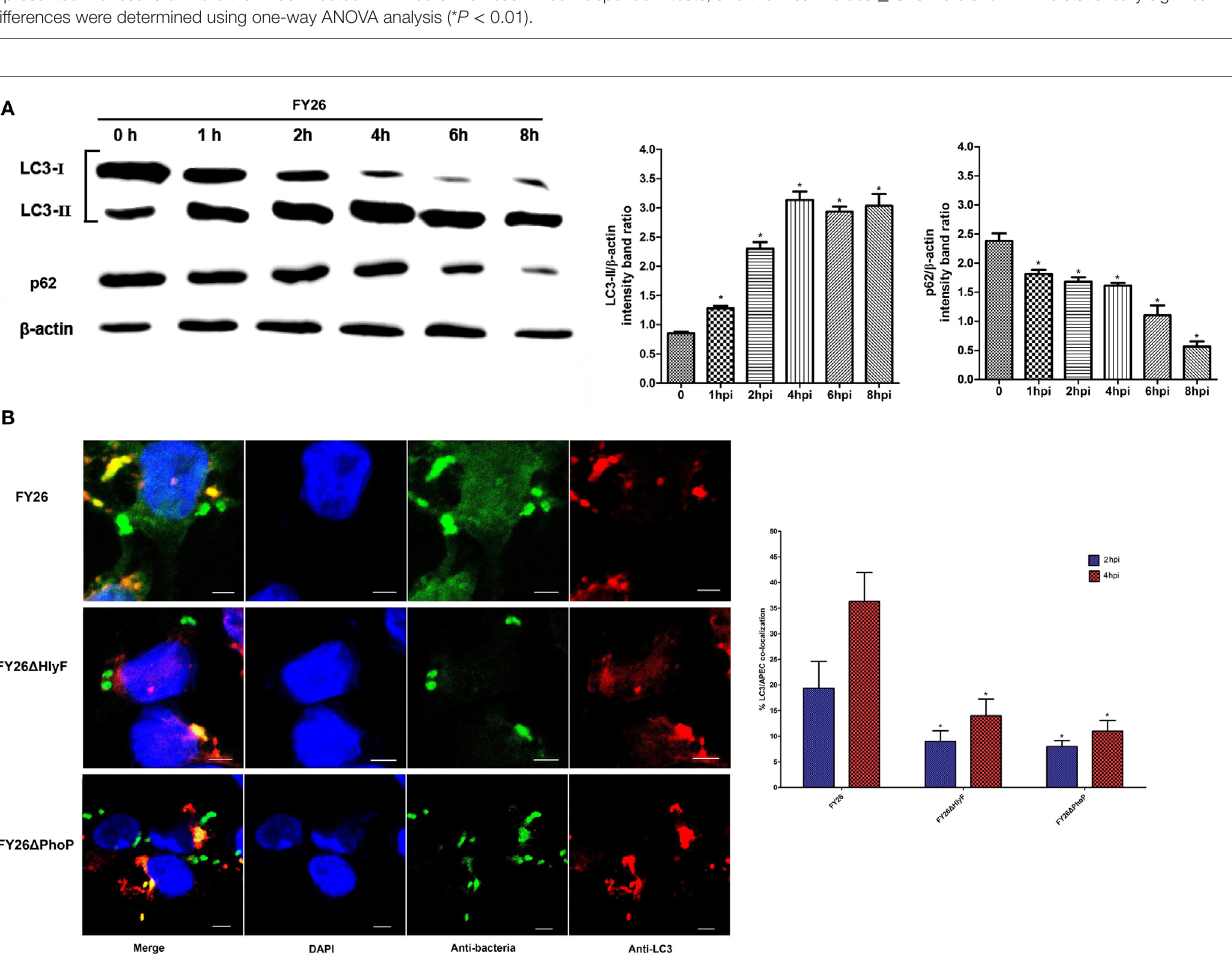
FigUre 6 | PhoP/PhoQ-HlyF pathway promoted the formation of extraintestinal pathogenic Escherichia coli (ExPEC)-containing autophagosome during survival in macrophages. (a) Western blots of LC3 and p62 in FY26-infected HD11 cells. HD11 cells were infected with FY26 at multiplicity of infection (MOI) of 50. At 1, 2, 4, 6, or 8 h post-infection (hpi), the cells were lysed, and SDS-PAGE was performed. Western blot using antibodies against LC3, p62, and β -actin protein as indicated. Densitometry analysis was performed to relative quantification. The data for the ratio of LC3-II and p62 to β -actin were acquired from three independent experiments, and the mean values ± SEs were shown. The statistically significant differences were determined using one-way ANOVA analysis (* P < 0.01). (B) To determine the colocalization rates of LC3 with wild-type FY26, FY26 Δ HlyF, and FY26 Δ PhoP at an MOI of 5. Bacteria were labeled with an anti-ExPEC antibody (Alexa 488, green) and anti-LC3 antibodies (Alexa 568, red). DNA was dyed with DAPI (blue). Representative confocal microscopy images (the left side of Figure 6B ) for 2 hpi were shown. Scale bar = 5 µm. Quantification of the colocalization rates of ExPEC strains with LC3 at 2 and 4 hpi was shown in right side of Figure 6B . Data for quantification of the colocalization rates represented the results of more than 100 infected HD11 cells in each of least three independent tests, and the mean values ± SEs were shown. The statistically significant differences were determined using one-way ANOVA analysis (* P < 0.01).